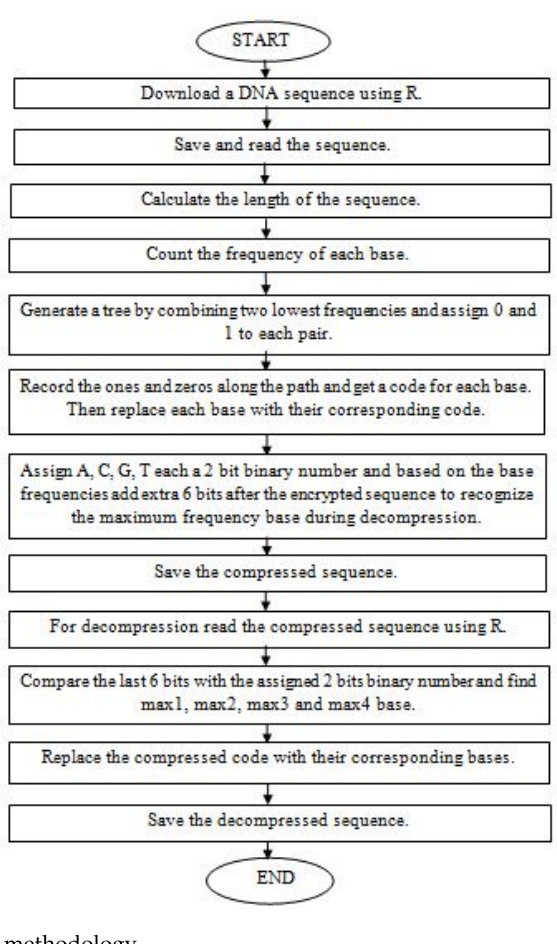
Figure 1: Flowchart of proposed